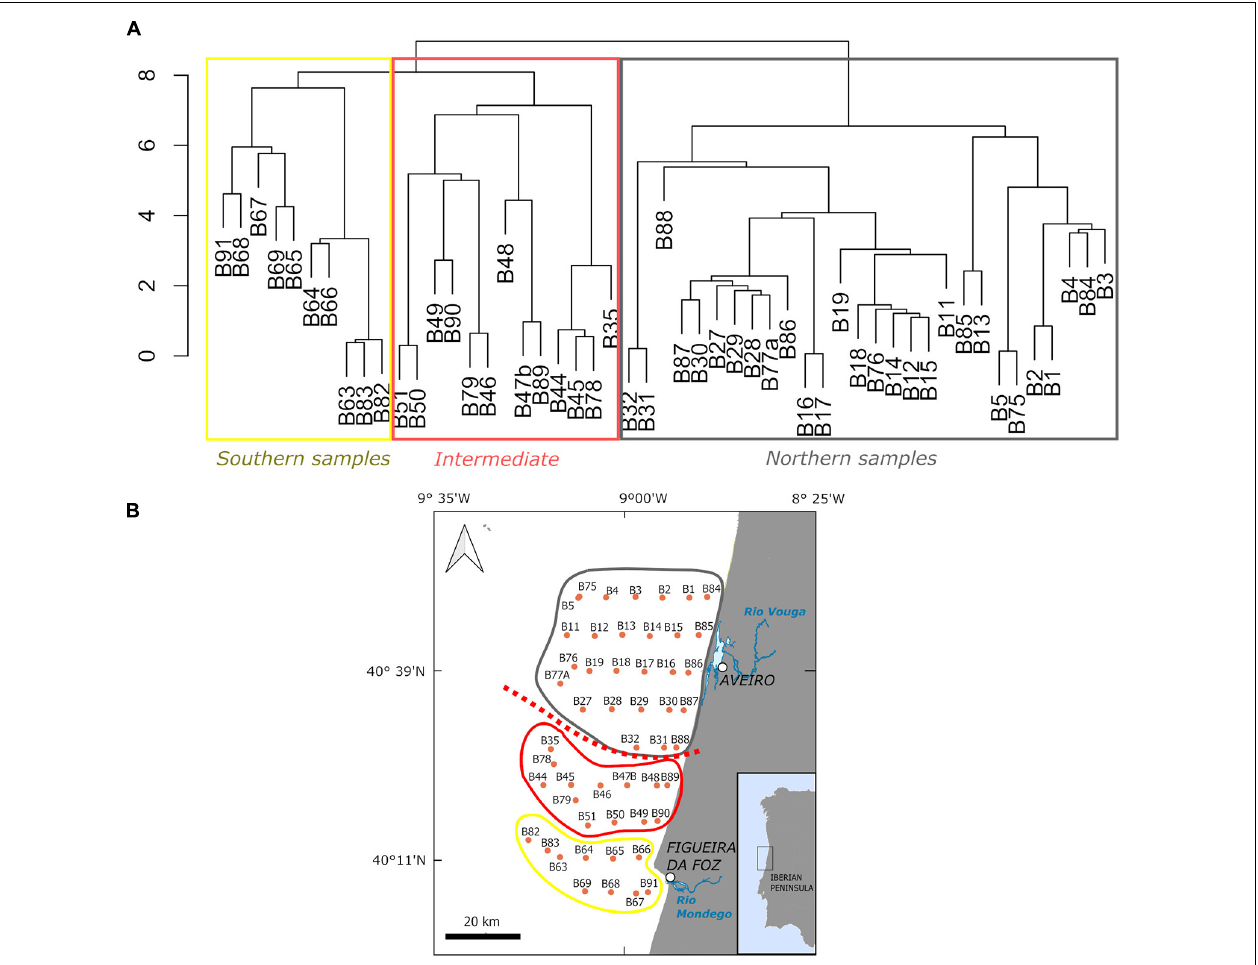
FIGURE 8 | Classification results from cluster analysis (constrained by latitude) performed on untransformed percentage data using Bray Curtis dissimilarity distances and Coniss method (A) . The dashed red line in the map (B) separates the main two groups of samples according to the highest differences in their cyst